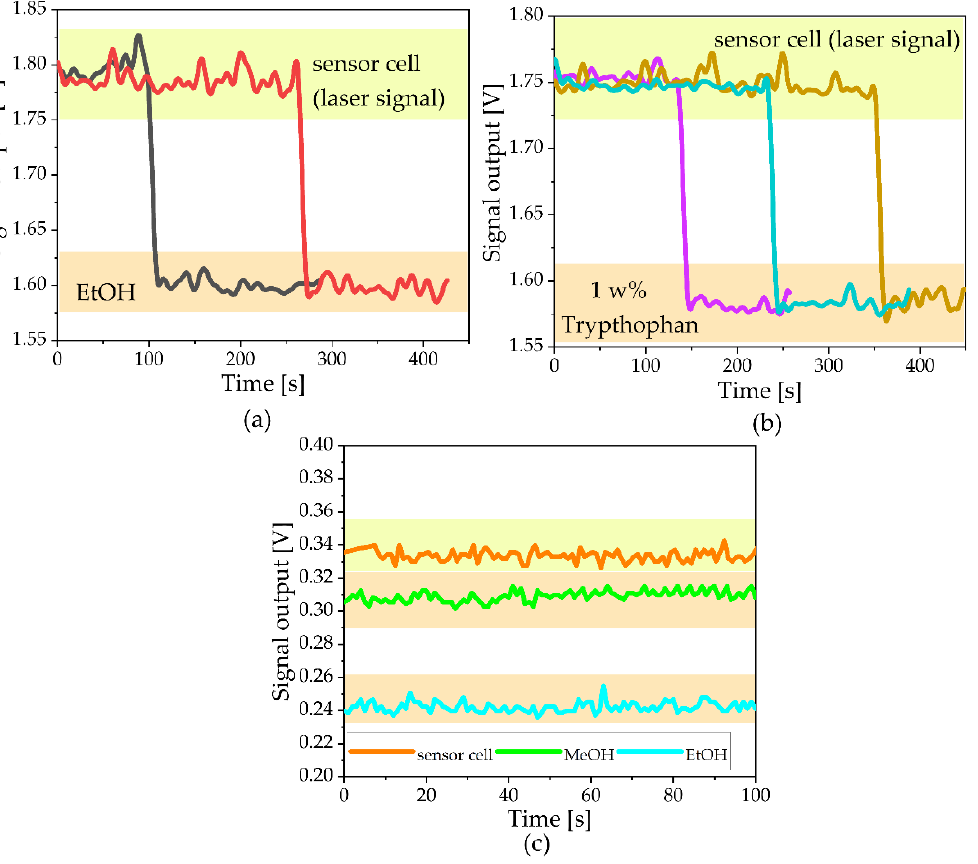
Figure 4. Measurements were executed with the hollow waveguide coupled RobustATR assembly of ( a ) ethanol and ( b ) 1 w% tryptophan deposited at the IRE surface. Data were treated using a five-point FFT filter; ( c ) measurements were performed with the QCL directly coupled into the sensor assembly (i.e., without fiber coupling); no data treatment was used.